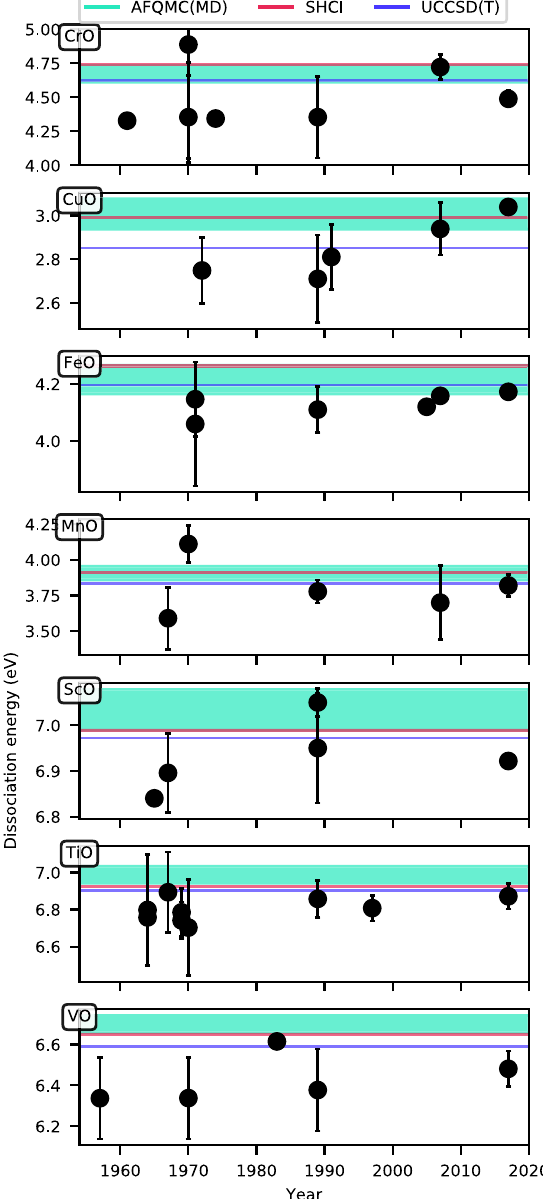
FIG. 5. Comparison of 5 z dissociation energies of the transition metal molecules obtained from the more accurate methods used in this work to experiment. The x axis is the year the experimental result was published, and the width of the bars indicates statistical or systematic